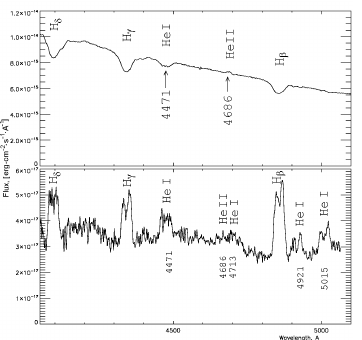
Figure 11: Spectrum of the object in outburst (May 4/5, 2013) and quiescence (August 2/3,